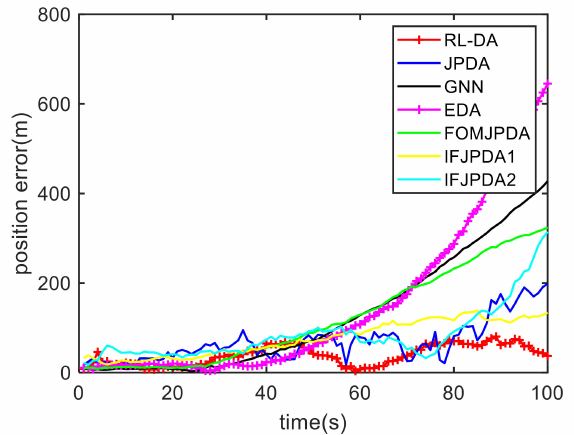
Figure 13. Comparison of the position errors for Target 1 in Case 1.